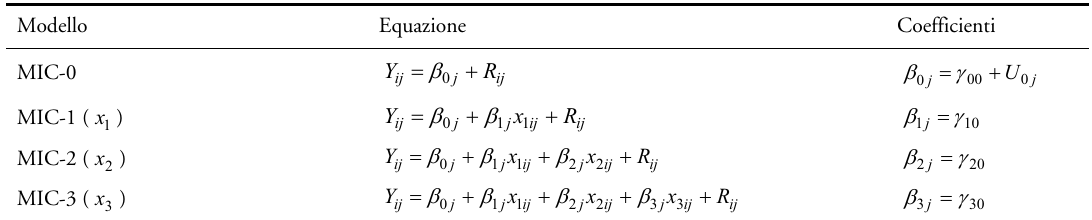
Modelli ad intercetta casuale con diverse variabili